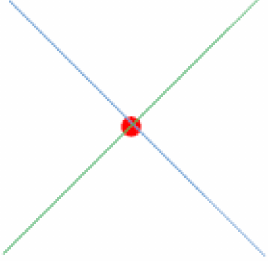
Figure 2 . In a smooth Lorentz-signature spacetime, every codimension-2 surface (red dot) is approached by four orthogonal null congruences. These approach from future-left and past right (both blue), and from future-right and past left (both